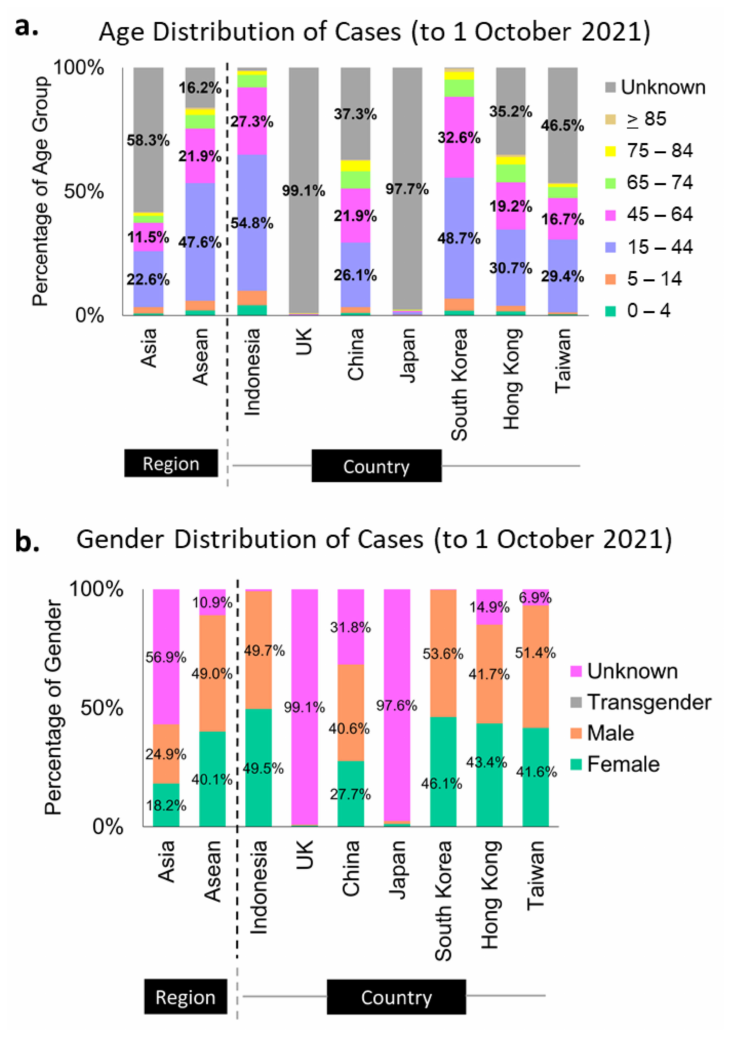
Figure 2. Metadata profiles of some Asian countries and the UK. Indonesia and South Korea submit- ted almost complete metadata of age ( a ) and sex ( b ) categories to